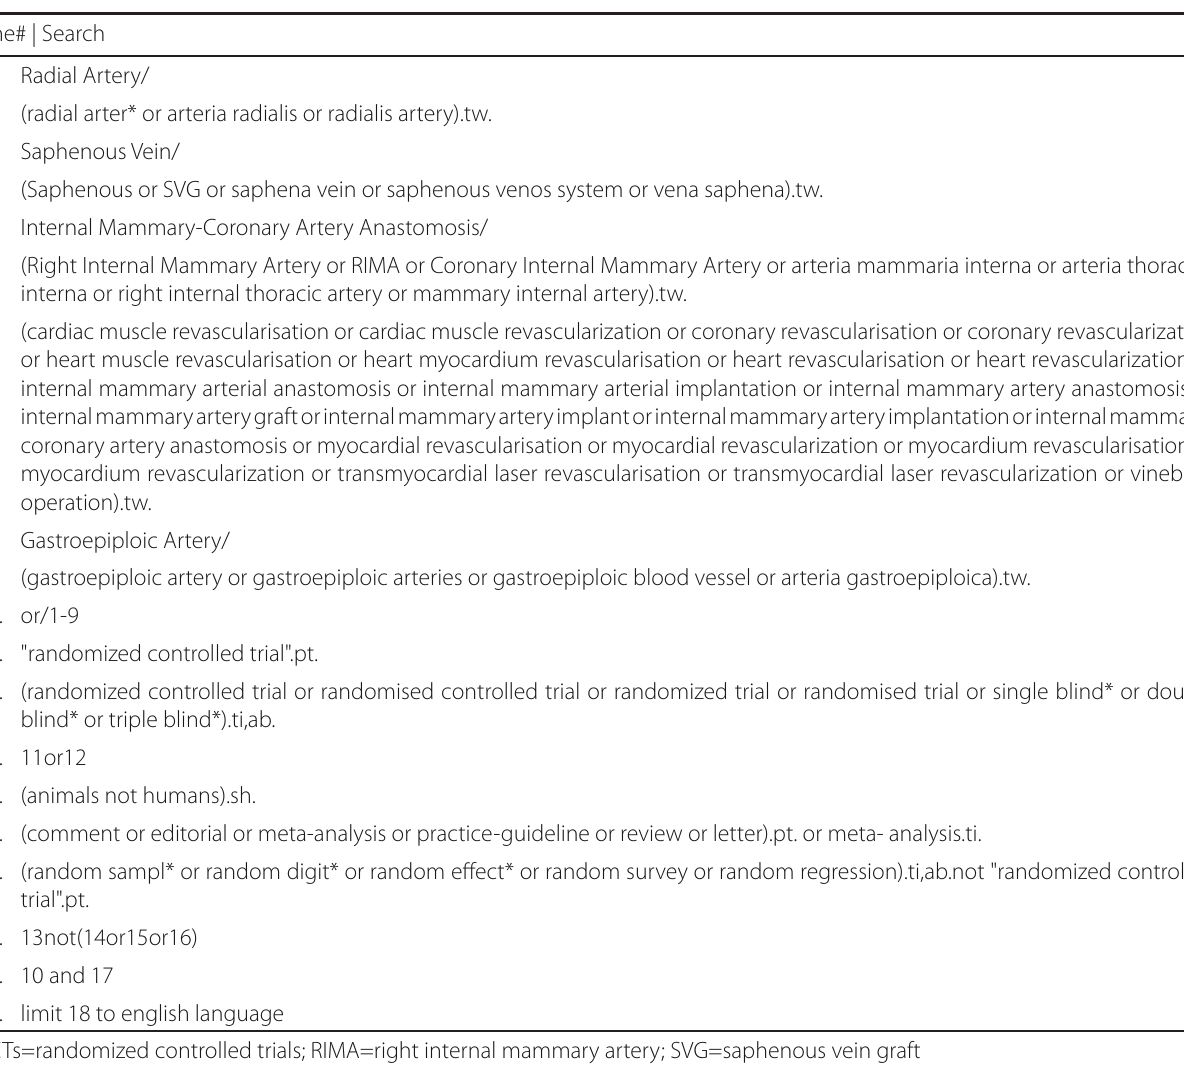
Table S1. Search Strategy. Ovid® MEDLINE® (ALL - 1946 to December 22, 2021). Searched on 12/22/2021. Limited to English language